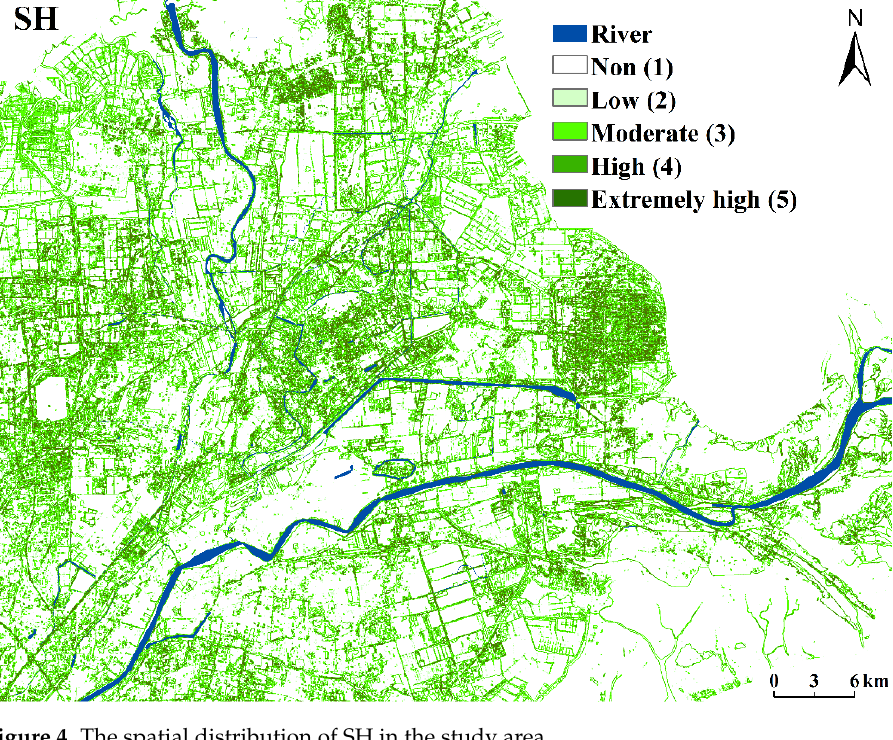
Figure 4. The spatial distribution of SH in the study area.